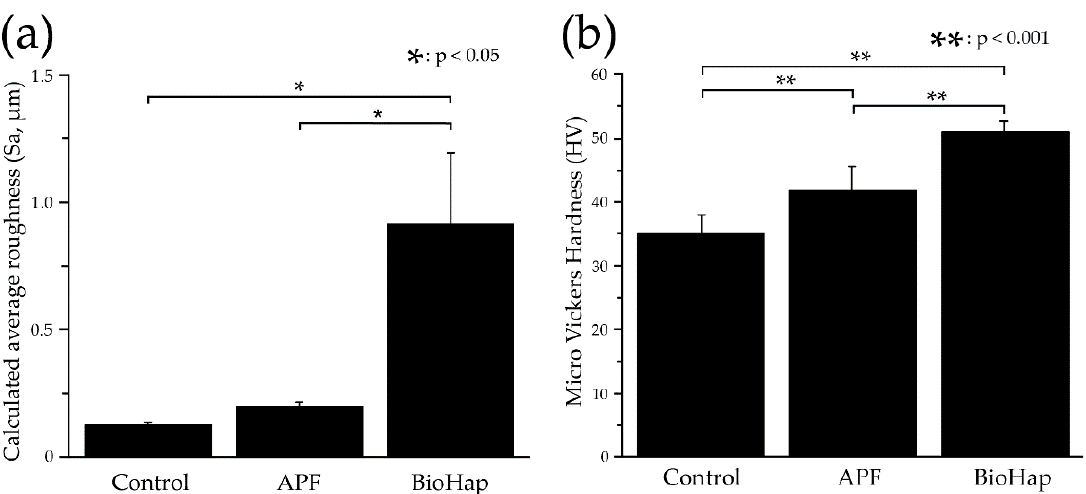
Figure 2. Comparison of calculated average roughness (Sa) and Micro Vickers hardness measure- ments of experimental surfaces after acid challenge. ( a ) Graph of Sa ( n = 9). The horizontal axis indicates various preventive treatments, and the vertical axis indicates the Sa ( µ m) of the experimental surface. ( b ) Graph of Micro Vickers hardness ( n = 9).